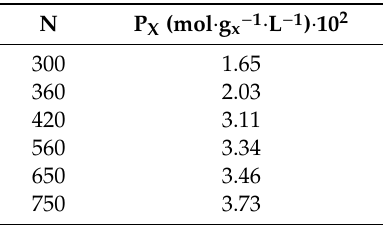
Table 2. Productivity results achieved in STBR